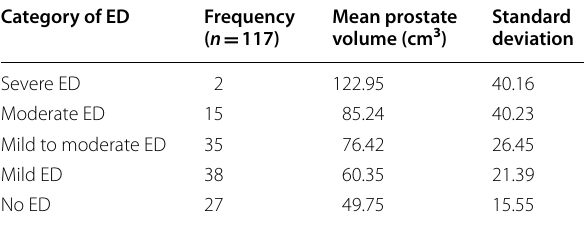
Table 4 Severity of ED and mean prostate volume in 117